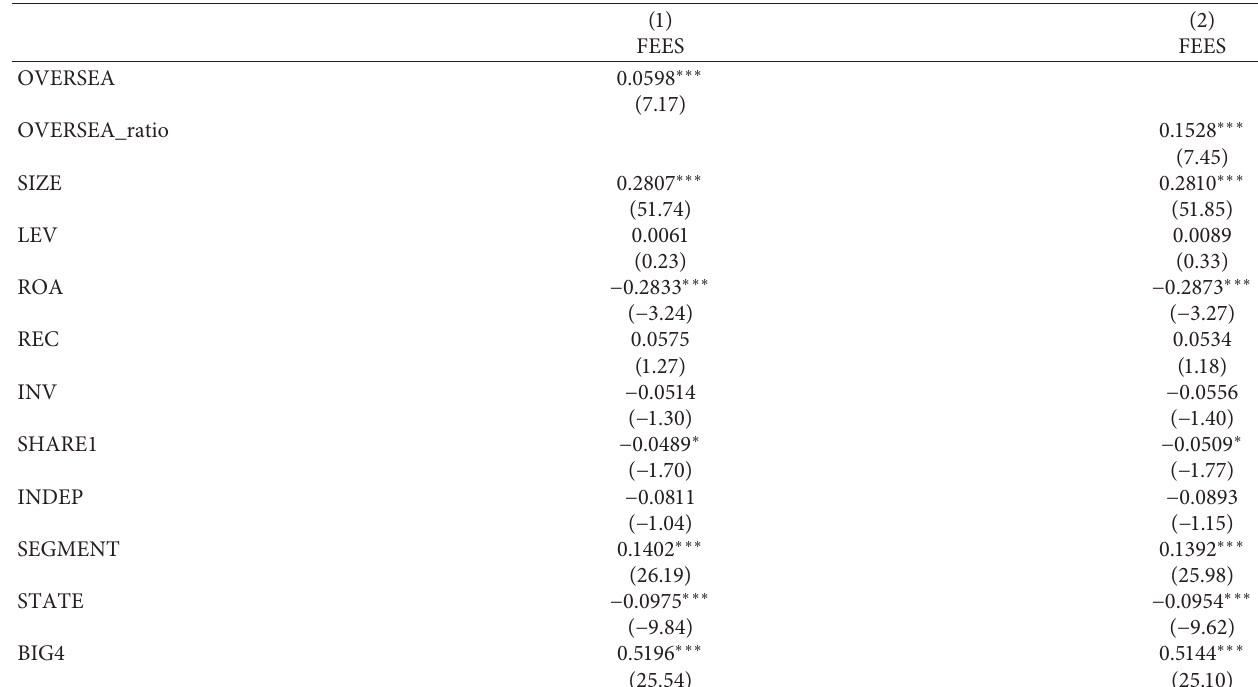
Table 12: Propensity score